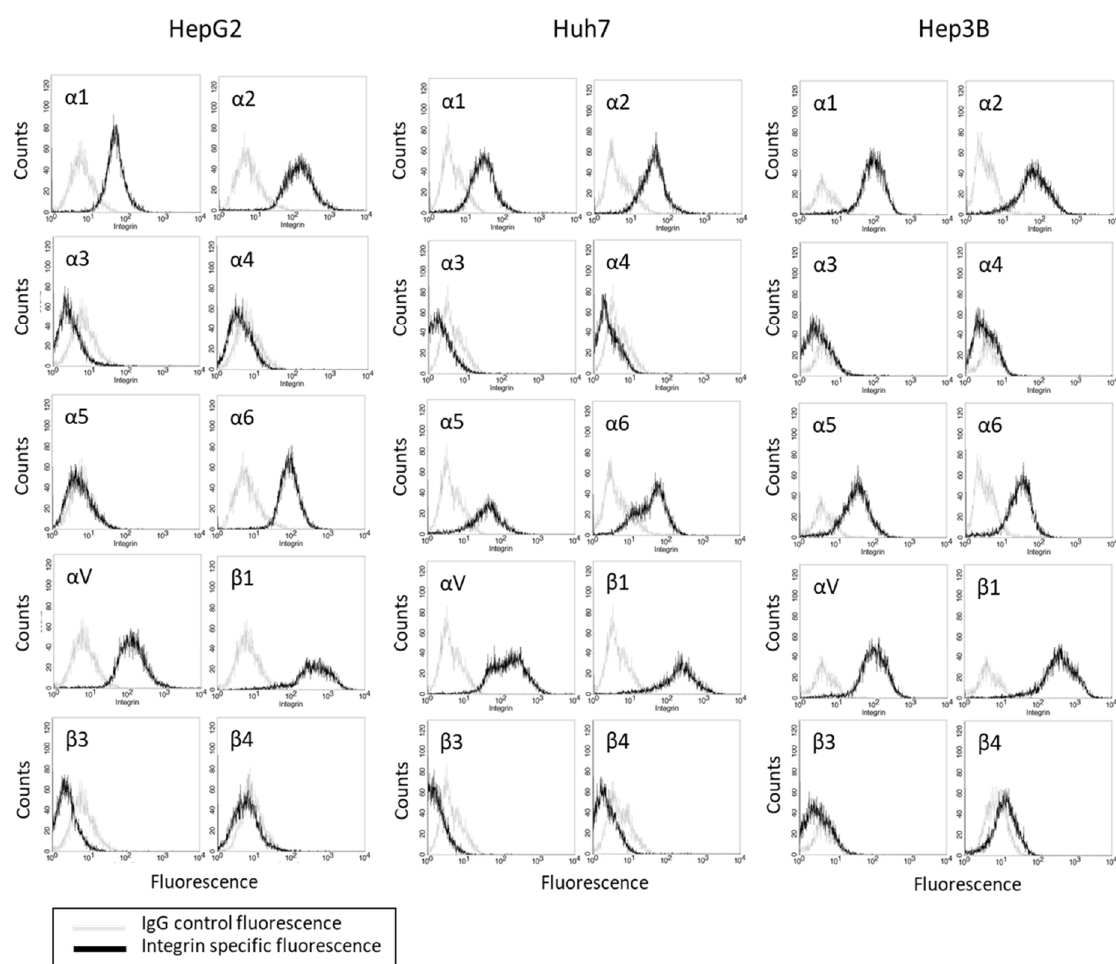
Figure 2. Integrin α and β expression profile on HepG2, Huh7, and Hep3B cells. Cell number (Counts) versus fluorescence intensity is depicted (one representative of three separate experiments). Black line = specific fluorescence, grey line = isotype control.